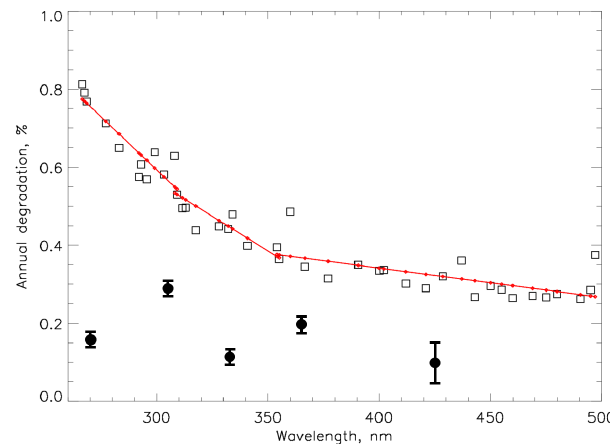
Figure 30. The annual signal change rates (QVD diffusor, squares) derived from the wavelength-binned solar irradiances for 2007– 2009 (see more details in Marchenko and Deland, 2014) and fitted with linear polynomials (red lines) for each OMI channel. Filled cir- cles and ± σ error bars show the degradation estimates in the OMI